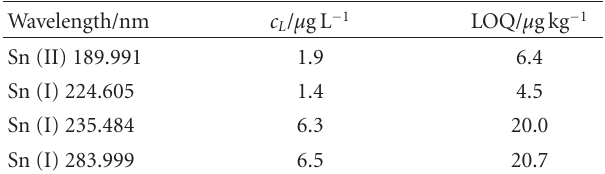
Table 2: Method detection limits ( c L ) and limits of quantification (LOQ) for